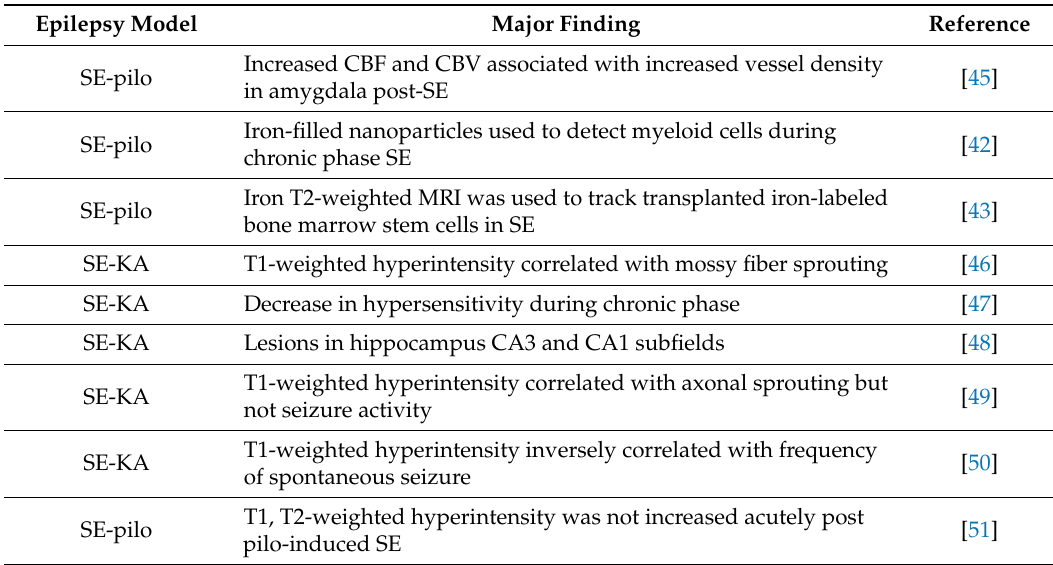
Table 4. List of iron oxide contrast and manganese-enhanced MRI studies and potential biomarkers for